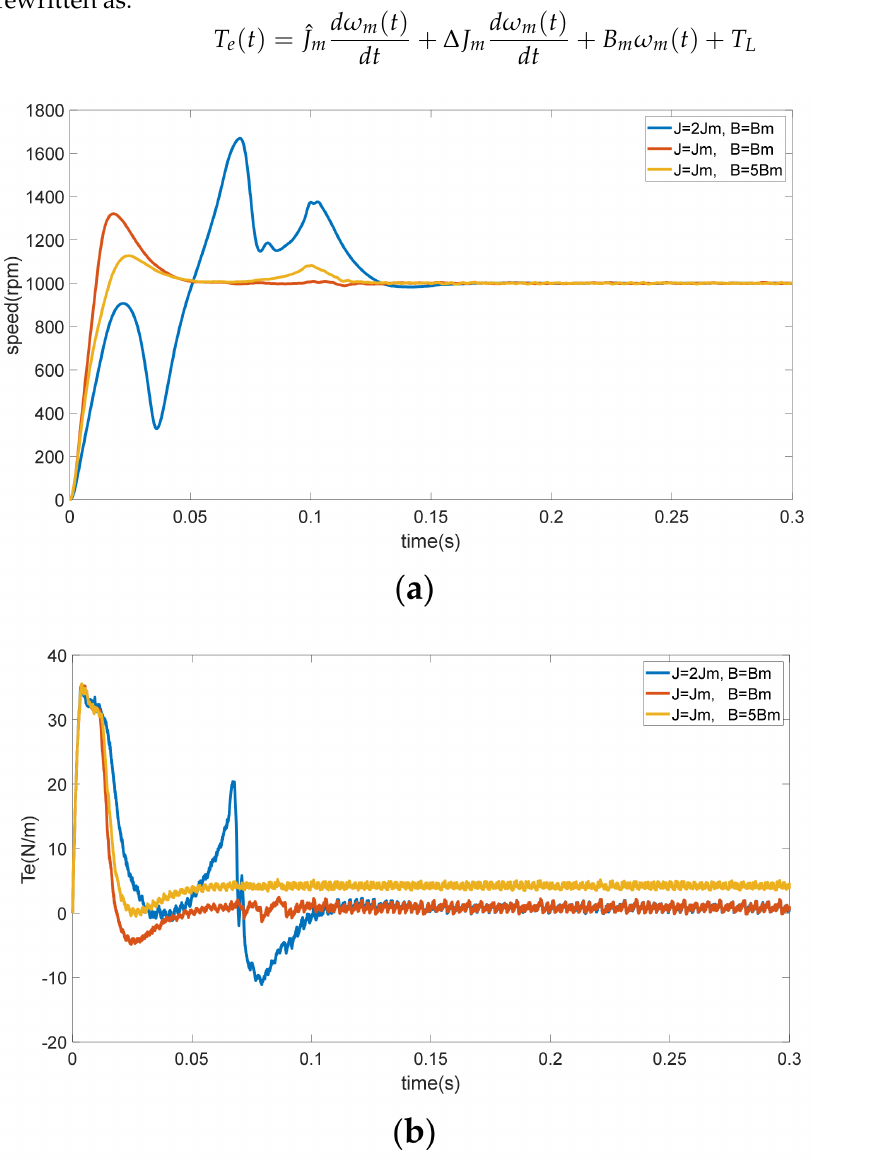
Figure 1. Comparisons in the case of J = J m , J = 2 J m , B = 5 B m . ( a ) Speed response. ( b ) Torque